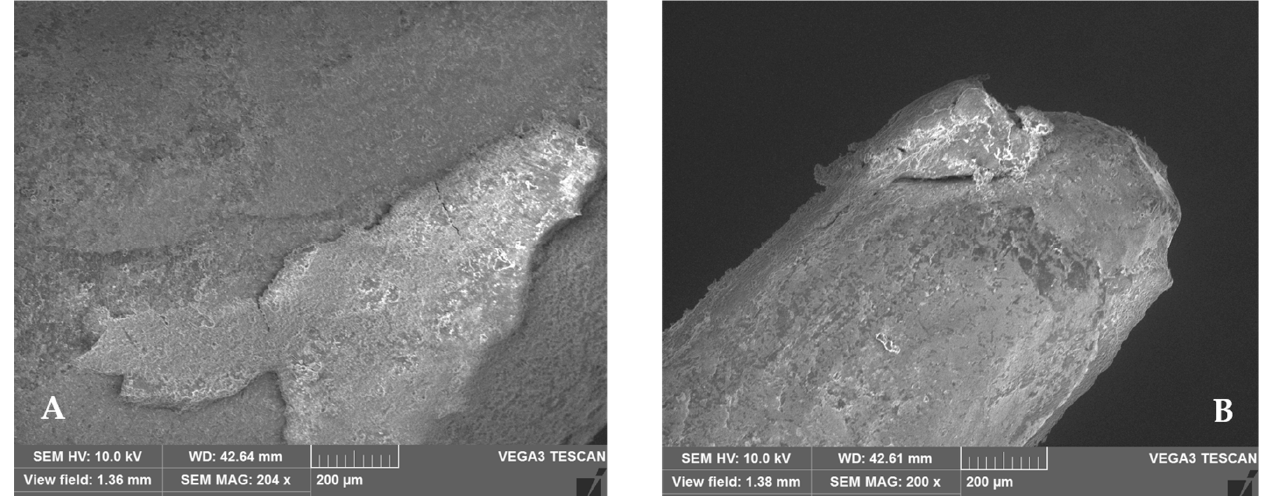
Figure 12. Scanning-electron-microscope image of ( A ) Sectioned root canal, and ( B ) displaced post, at 200× magnification, showing cohesive failure mode in Group 4 (CMZPCs) sample at root/post interface.